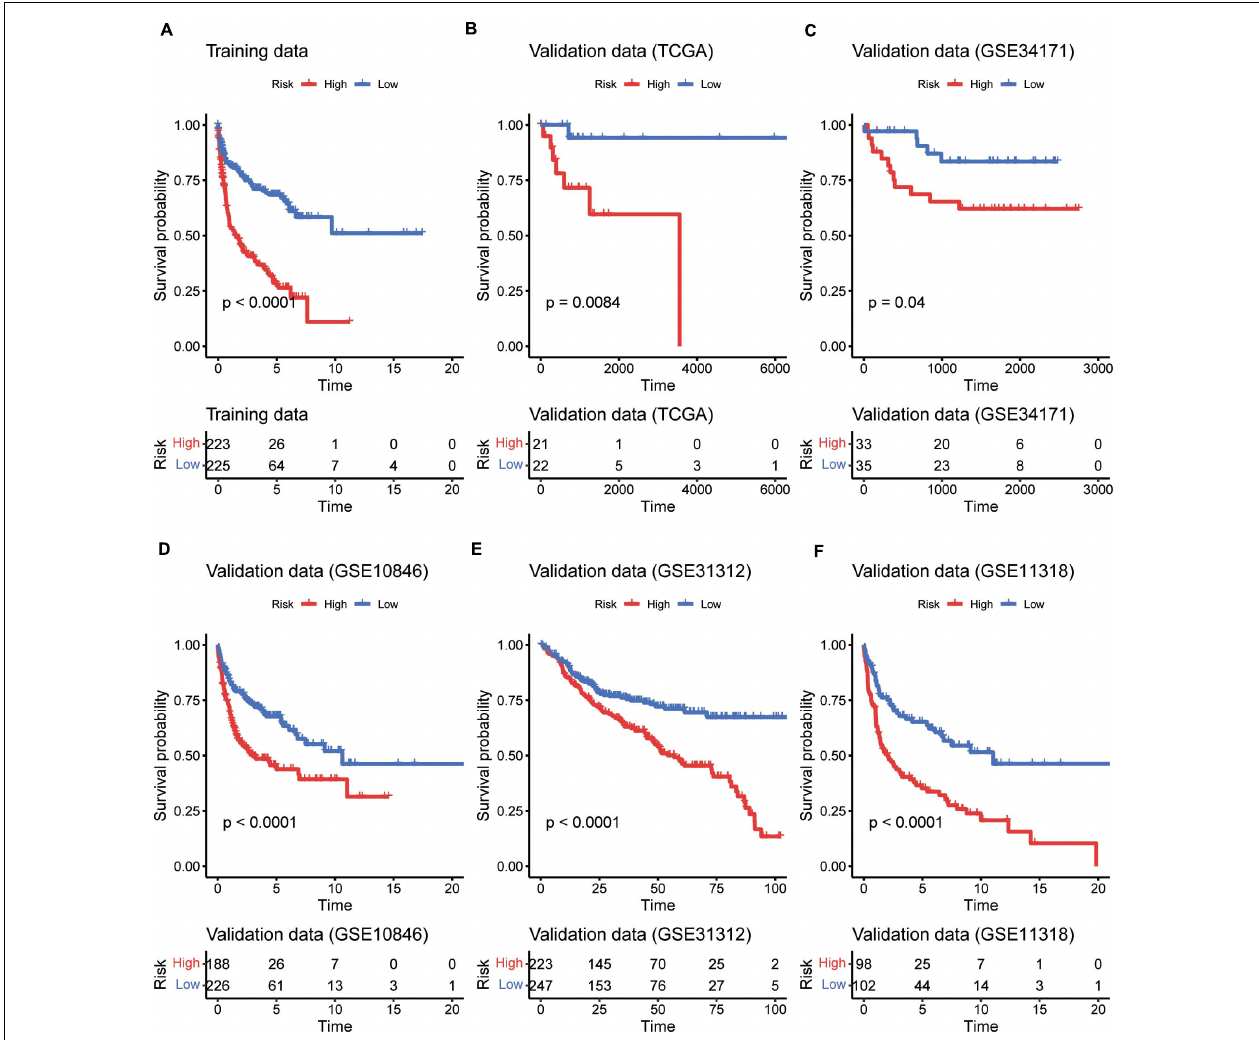
FIGURE 2 | The performance of the five gene signatures in predicting the patients’ risk. K-M curves for the prognostic model in the training datasets (A) and the five validation datasets (B–F) . The red and blue lines represent the high- and low-risk groups, respectively. The numbers within risk tables on the bottom represent the number of survivors at that time